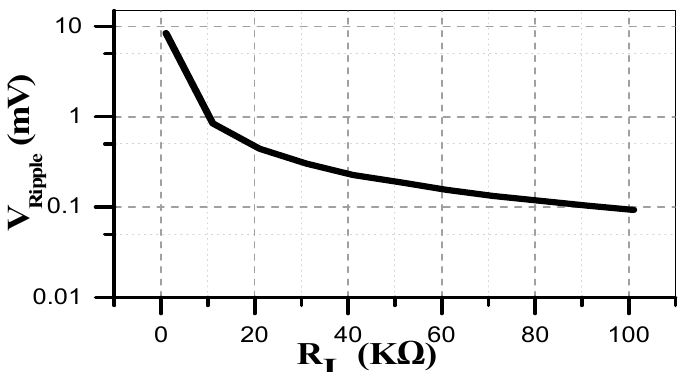
Figure 21. The post-layout simulation results of the output voltage ripple of the proposed SSC-DVS versus the flying capacitor C when V in = 1.5 V, R L = 2 K Ω , and F SW = 50 MHz.